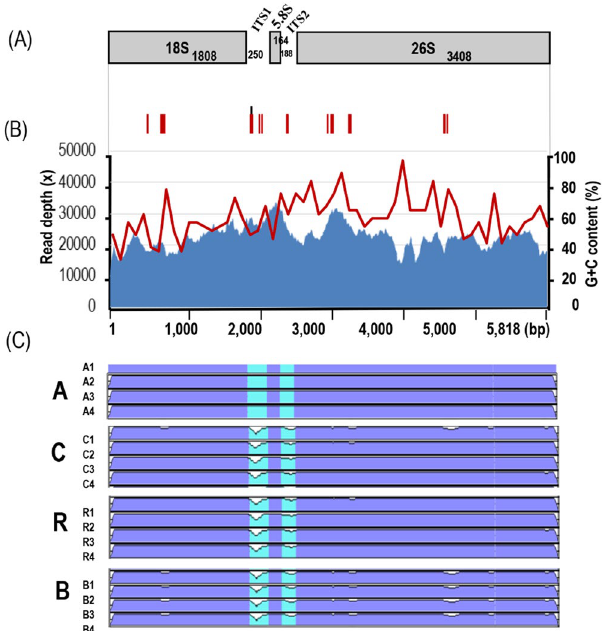
Figure 4. Structure and similarity analyses of 45SnrDNA sequences from 28 Brassica and Raphanus genotypes. ( A ) Complete structure and gene annotation of 45SrDNA sequences from the A1 genome. ( B ) Red and black arrowheads indicate the SNP and InDel variations, respectively. ( C ) Coverage of 45SnrDNA-based read mapping. Red lines indicate the proportion of G + C in the 4S 45SnrDNA. ( D ) Comparative analysis of similar and variable regions using mVISTA. Red arrowheads indicate inter-species variations.